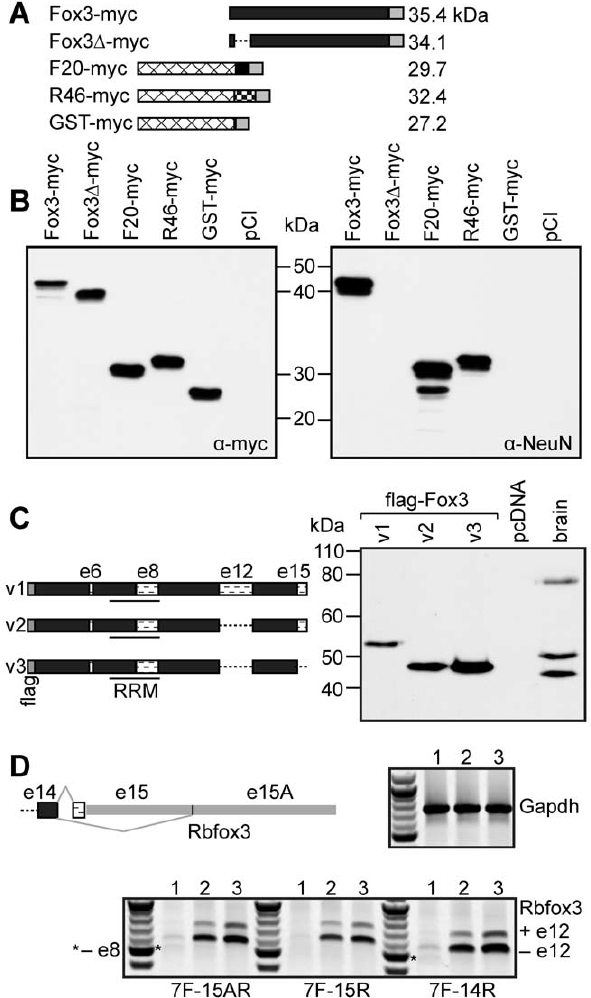
Figure 3. The anti-NeuN epitope of Rbfox3 maps to the extreme N-terminus of the protein. A,B. The proteins depicted in A were expressed in 293T cells and analyzed by western with anti-myc- tag (left panel), or anti-NeuN antibodies on duplicate blots. Anti-NeuN recognises both F20 and R46, and amino acids 5–20 (deleted in Fox3 D - myc) are necessary for recognition of full-length Rbfox3 by anti-NeuN. C. Three Rbfox3 splice variants were expressed in HeLa cells and compared to NeuN from mouse brain by western with anti-NeuN. Variant 1 (v1) corresponds to NP_001034256, v2 to NP_001034257, and v3 to NP_001020102. Exon numbers are as described in [13]. D. RT-PCR of total RNA from P19 cells prior to neuronal induction (lanes 1), P19 cells 7 days after neuronal induction with RA (lanes 2), and P10 mouse brain (lanes 3). For Rbfox3, 3 reverse primers were used to assess mRNAs that encode the short C-terminus (or -IGTM protein isoforms, 15A-R), the longer, -FTPY isoforms (15-R), or all mRNAs (14-R). A common forward primer to exon 7 (7-F) was used for all. Gapdh was used as a loading control.